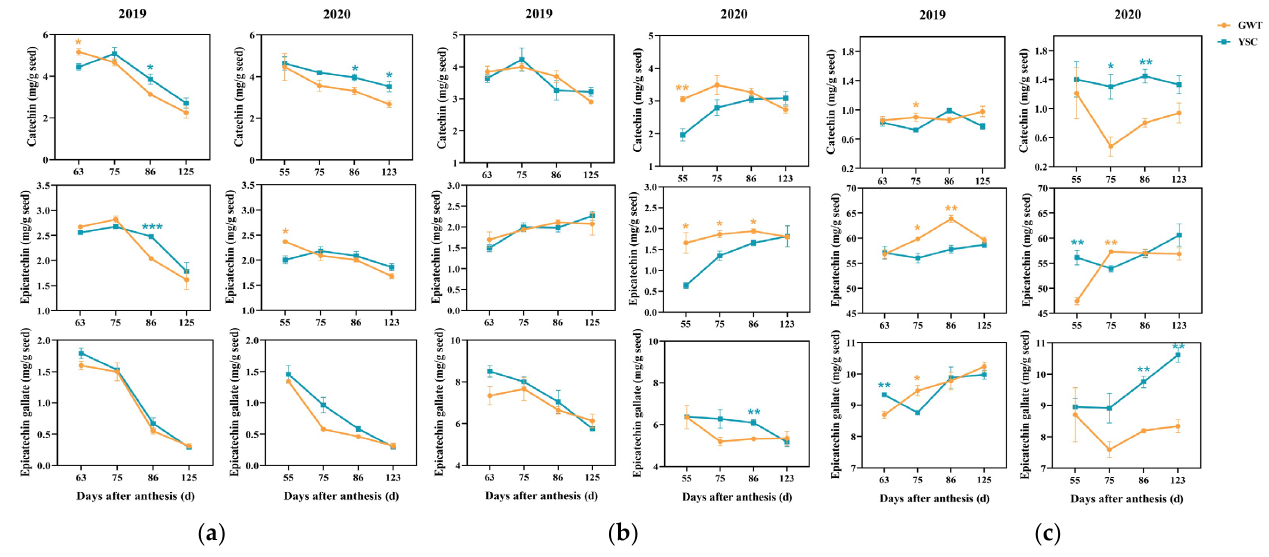
Figure 5. Changes in the content of free flavan-3-ol monomers ( a ), terminal units ( b ), and extension units ( c ) in soluble CT of GWT and YSC seeds. The asterisk indicates that there is a statistical differ- ence between the 2 vineyards in the same period at the 0.05 level: *, p < 0.05; **, p < 0.01; ***, p < 0.001.